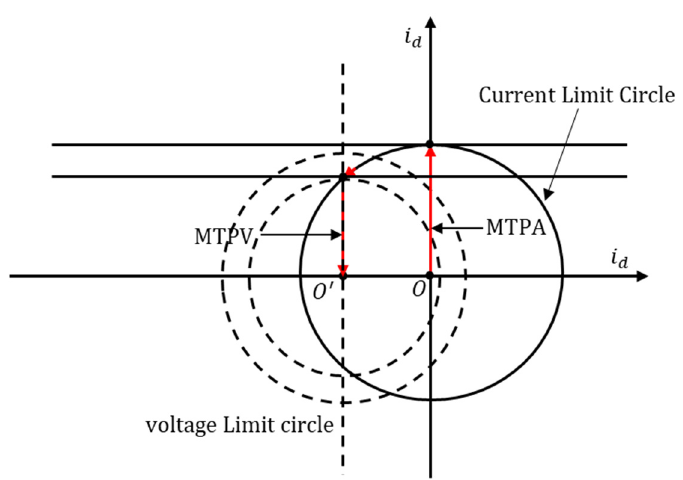
Figure 2. The current and voltage limit circle of SPMSM under d-q axis.